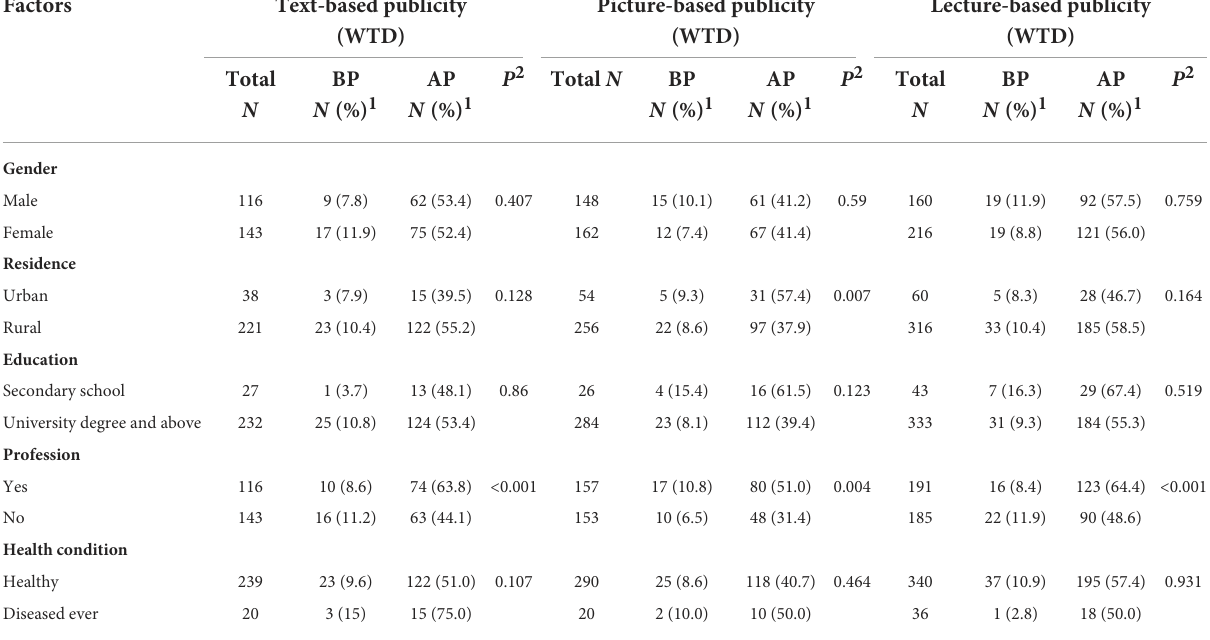
TABLE 3 Factors influencing the effectiveness of text-based, picture-based, and lecture-based publicity in improving willingness to donate.